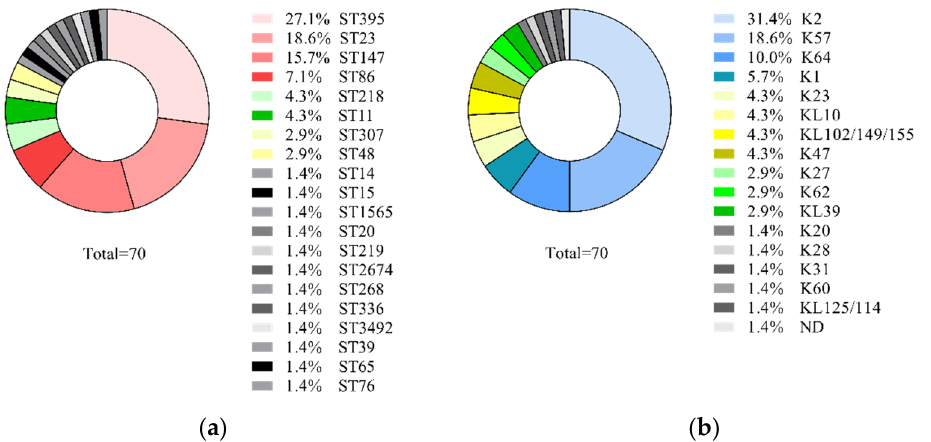
Figure 1. Prevalence of K. pneumoniae genetic lines among 70 isolates collected in Neuro-ICU in 2014–2019: ( a ) sequence types; ( b ) capsular types.